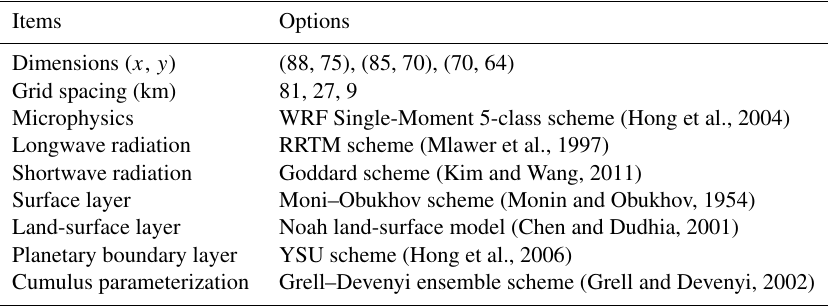
Table 1. The grid settings and the physical options for WRF in this study.